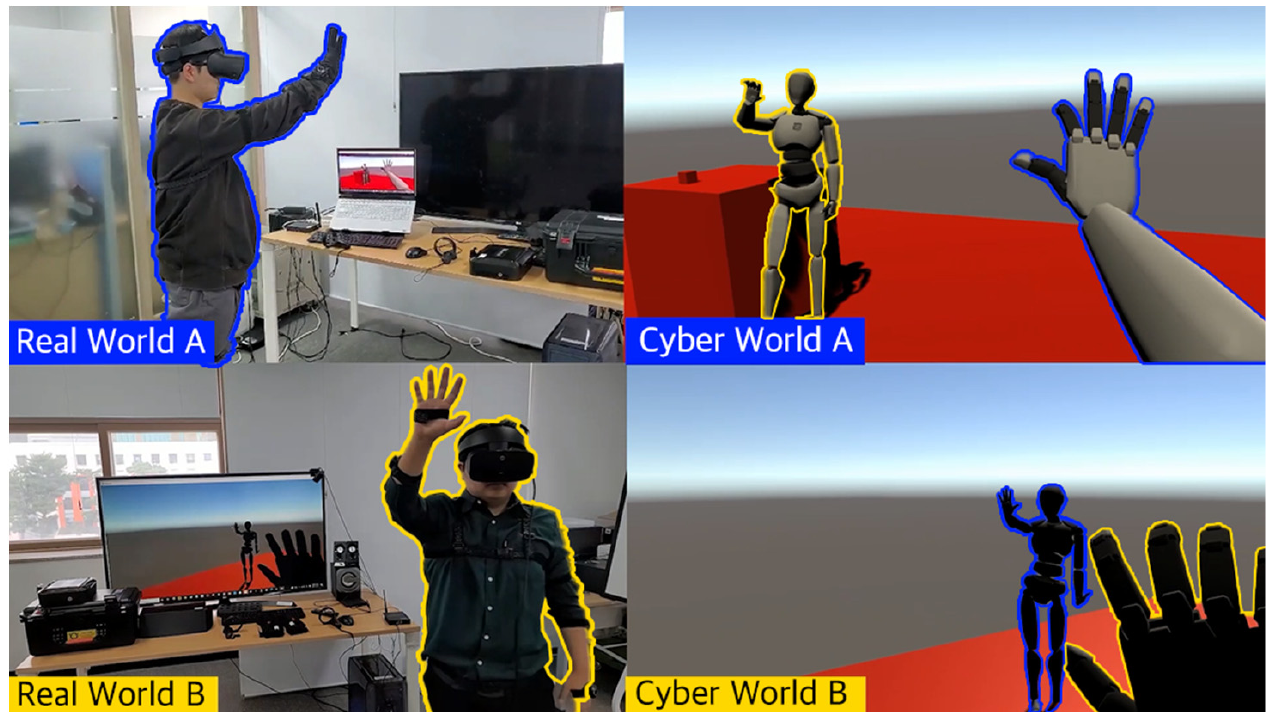
Figure 7. Remote collaboration system demo.